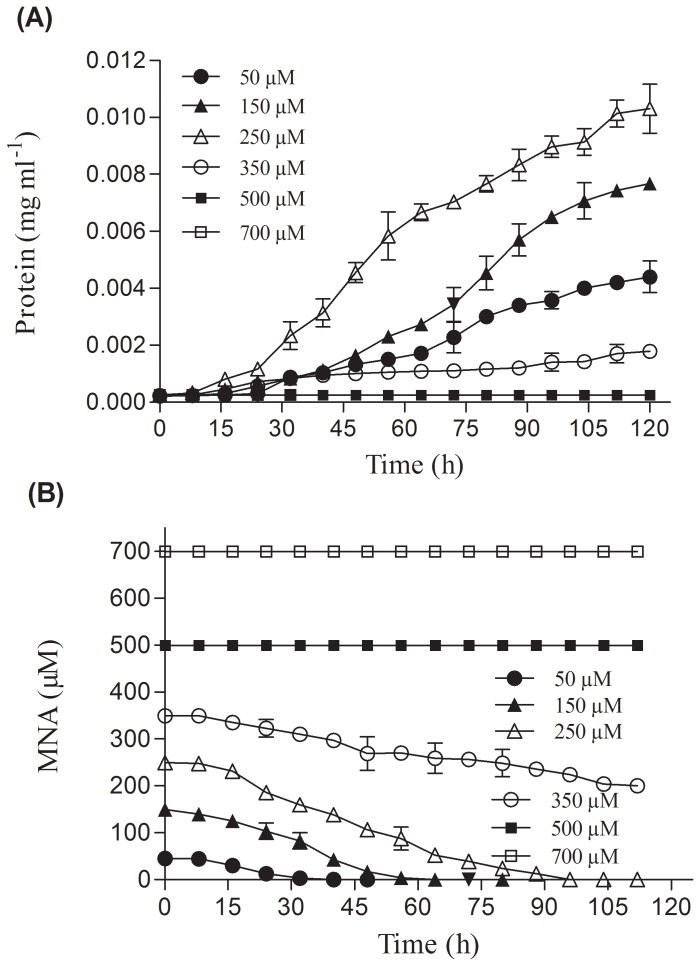
Growth characteristics and degradation kinetics of Pseudomonas sp. strain FK357 in carbon-free MSM supplemented with different concentrations of MNA.(•), 50 µM; (▴), 150 µM, (Δ), 250 µM; (○), 350 µM; (▪), 500 µM; (□), 700 µM. (A) Growth of strain FK357 on different concentrations of MNA. (B) Degradation of MNA at different concentrations by strain FK357.